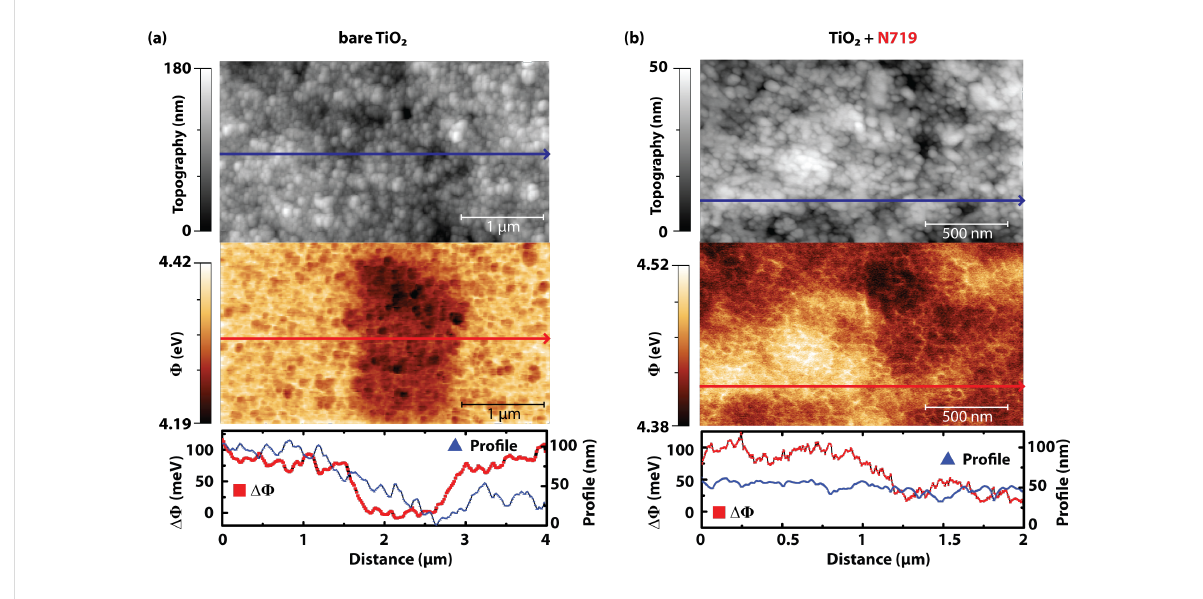
Figure 4: Topography and work function of (a) a bare TiO 2 and (b) an N719 sensitized TiO 2 layer with a thickness of ≈ 10 μ m revealing wide-spread inhomogeneities in the work function. The measurements correspond to a scan size of (a) 2 × 4 μ m and (b) 1 × 2 μ m. Imaging parameters: A free = 20 nm rms, A set = 70%, f 1st = 72 kHz, f 2nd = 452 kHz, U ac = 2 V, T = rt. The TiO 2 is a commercial product from Solaronix, Ti-Nanoxide